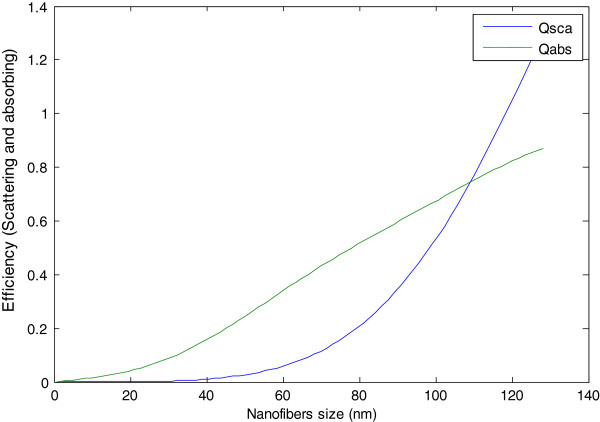
Theoretical calculations of QScaandQabsefficiencies with different particle sizes.